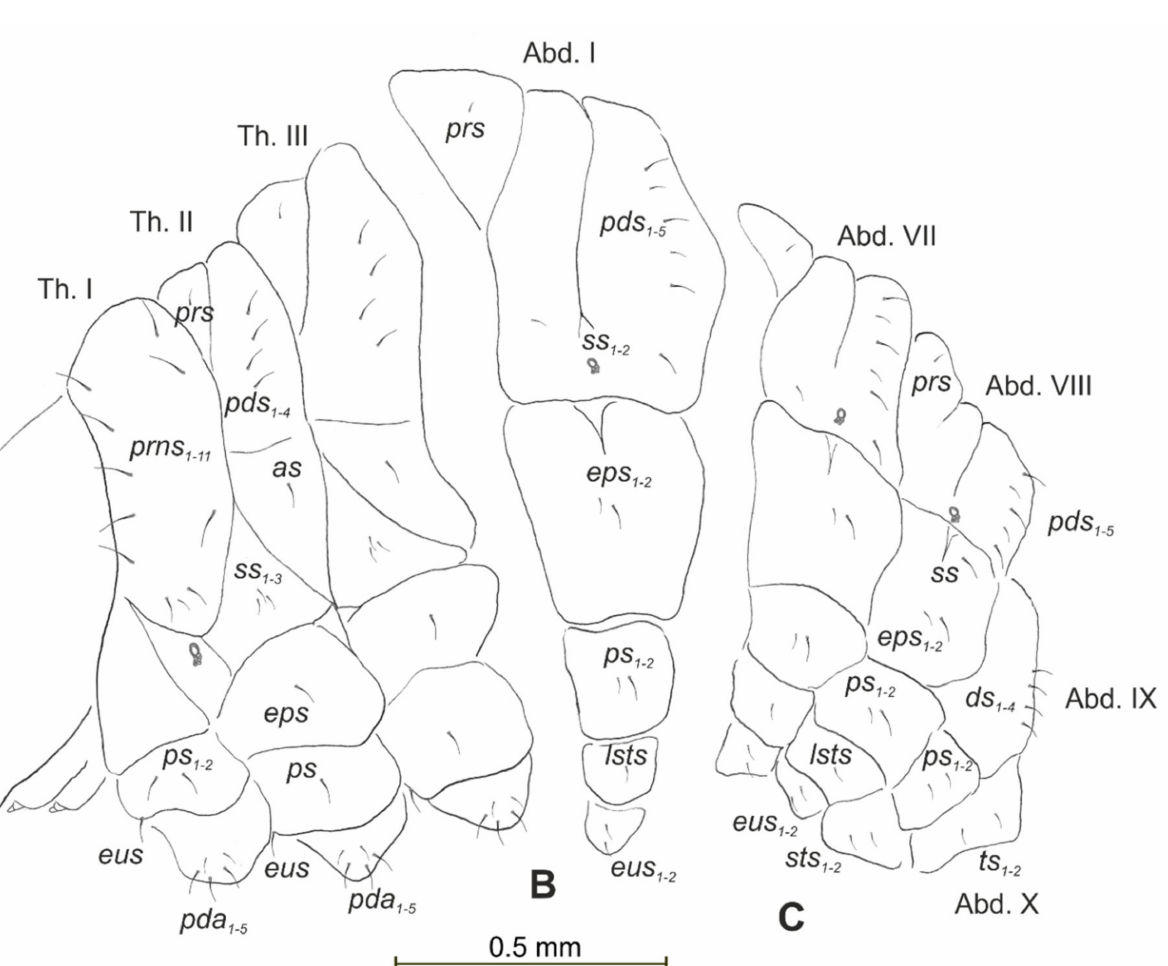
(Figure 13A) placed latero-ventrally on prothorax; abdominal spiracles (Figure 13B) placed medio-laterally on segments I–VIII. Chaetotaxy of thoracic and abdominal segments well- developed. Prothorax (Figure 12A) with 10 medium and one short prns (eight placed on pronotal sclerite, next three above the spiracle); two medium ps and one medium eus . Meso- and metathorax with one minute prs ; four medium pds , equal in length; alar area with one medium as ; three ss of various lengths (two short and one minute); one medium eps ; one medium ps and one medium eus . Pedal areas of thoracic segments with five pda of various lengths. Abdominal segments I–VIII (Figure 12B,C) with one minute prs ; five pds ( pds 1 , pds 3 and pds 5 medium, pds 2 and pds 4 short), two ss ( ss 1 minute, ss 2 medium; segment VIII with one medium ss 1 ); two eps (one medium and one minute); two ps (one medium and one minute); one medium lsts and two medium eus . Abdominal segment IX with four medium ds ; two ps (one medium and one minute) and two medium sts . Abdominal segment X with two ts equal in size on each of the lobes (Figure 12C).